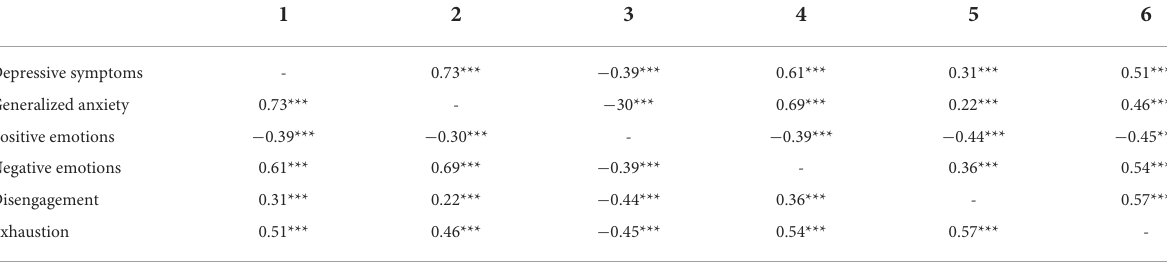
TABLE 3 Partial Pearson correlations of depressive symptoms, generalized anxiety symptoms, positive and negative emotions, and burnout controlling for age, redeployment to a different facility, COVID-19 dedicated workplace, work reorganizations, COVID-19 infection, psychological help at workplace, and economic status.